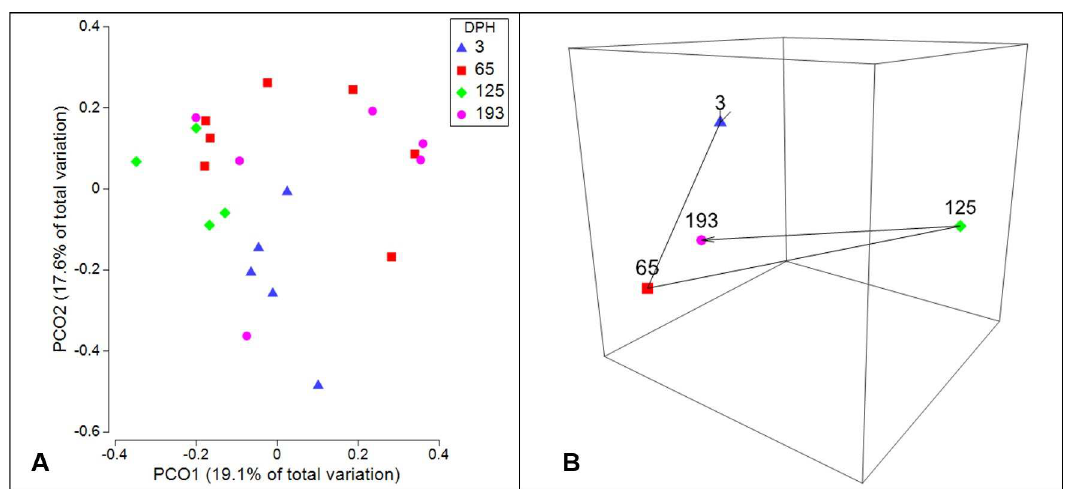
Fig 3. Visual presentations of the ontogeny of the intestinal microbiota of channel catfish using unweighted UniFrac beta diversity distances. (A) Principalcoordinates analysis(PCoA) plots of unweighted UniFrac distances obtainedfrom the intestinal microbiotaof channelcatfish at four distinct time points: 3, 65, 125, and 193 days post hatch (DPH). Points represent individual samples. (B) Non-metric multidemsional scaling(nMDS) plot showingthe trajectory of the intestinalmicrobiota of channelcatfish sampledover the first 193 dph. Individual points represent the group centroid (distancebased multivariate group mean) of each time point sampled.